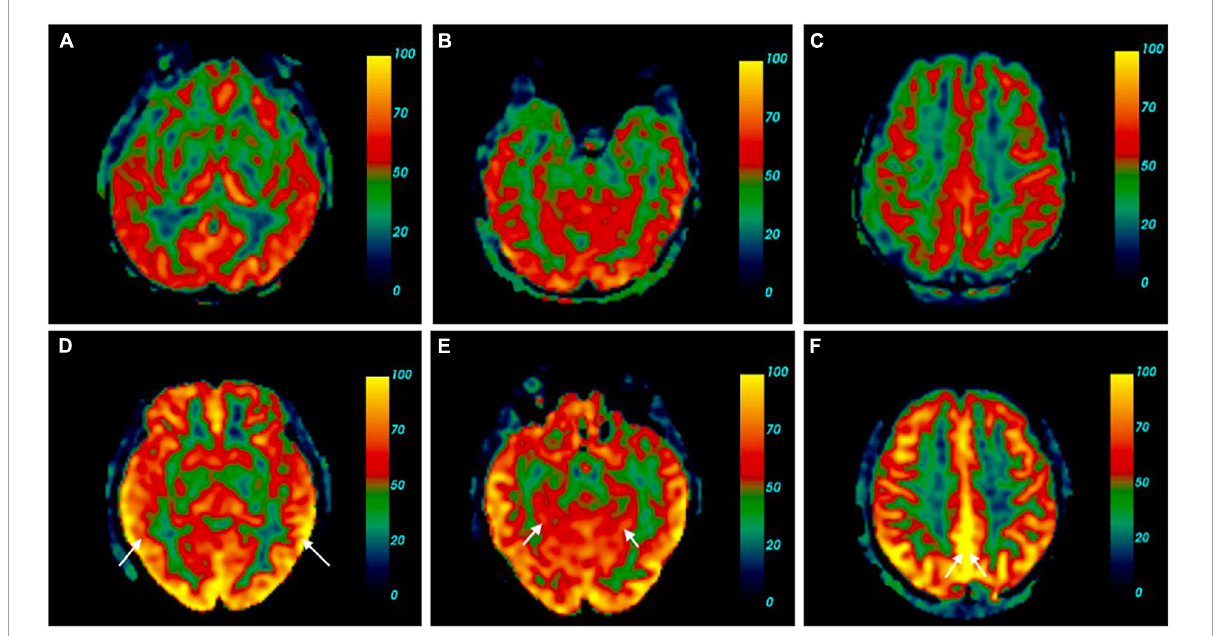
FIGURE2 Cerebral perfusion map contrast of SCD and HC. (A–C) Were cerebral blood flow maps from one of the HC. (D–F) Belong to a participant with SCD [female, 60 years old, complaint of memory decline for 2 years, sister has a history of dementia, mini-mental state examination (MMSE) 30, the Montreal Cognitive Assessment (MoCA) 29, SCD-Q9 6, and Apolipoprotein E (ApoE) ε 3/ ε 4]. Brain pseudo-continuous arterial spin labeling (pCASL) revealed the patient with SCD had increased cerebral perfusion, especially in the bilateral middle temporal gyrus (A) , the absolute CBF in the right bilateral middle temporal gyrus of the HC was 42.20 ml/100 g/min, the left was 37.49 ml/100 g/min. (D) The absolute CBF in the right bilateral middle temporal gyrus of the SCD was 67.69 ml/100 g/min, the left was 74.47 ml/100 g/min, parahippocampal gyrus (B) , the absolute CBF in the right parahippocampal gyrus of the HC was 27.59 ml/100 g/min, the left was 35.27 ml/100 g/min. (E) The absolute CBF in the right parahippocampal gyrus of the SCD was 50.99 ml/100 g/min, the left was 53.73 ml/100 g/min, precuneus (C) , the absolute CBF in the right precuneus of the HC was 39.44 ml/100 g/min, the left was 43.15 ml/100 g/min. (F) The absolute CBF in the right precuneus of the SCD was 71.42 ml/100 g/min, the left was 77.33 ml/100